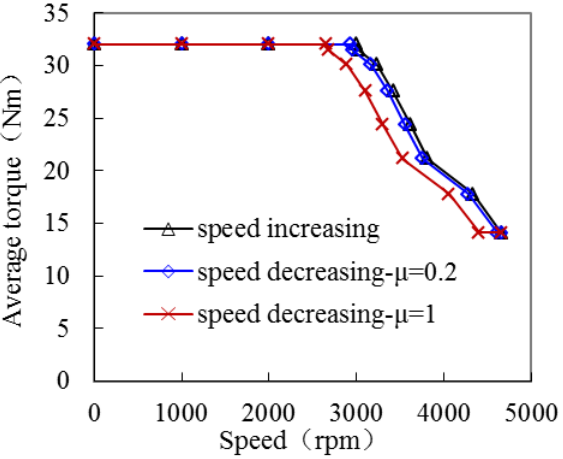
Figure 25. Relationship of average torque versus